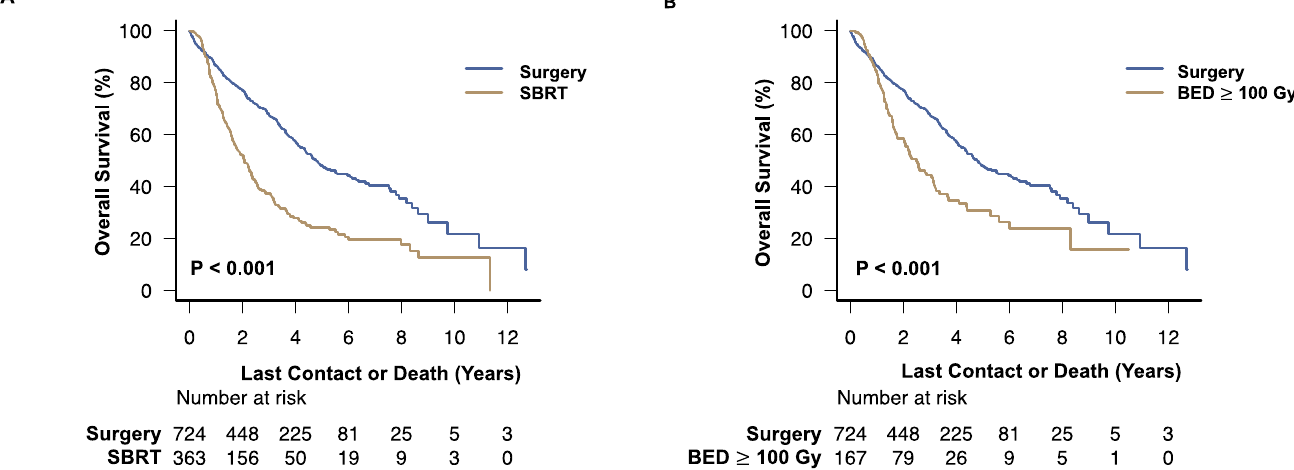
Figure 3. Overall survival in the propensity score matched study cohort with stage I or II hepatocellular carcinoma (log-rank test) ( A ). Overall survival in the subset of patients with a biologic equivalent dose (BED) ≥ 100 Gy versus surgery ( B ). SBRT, stereotactic body radiation therapy.